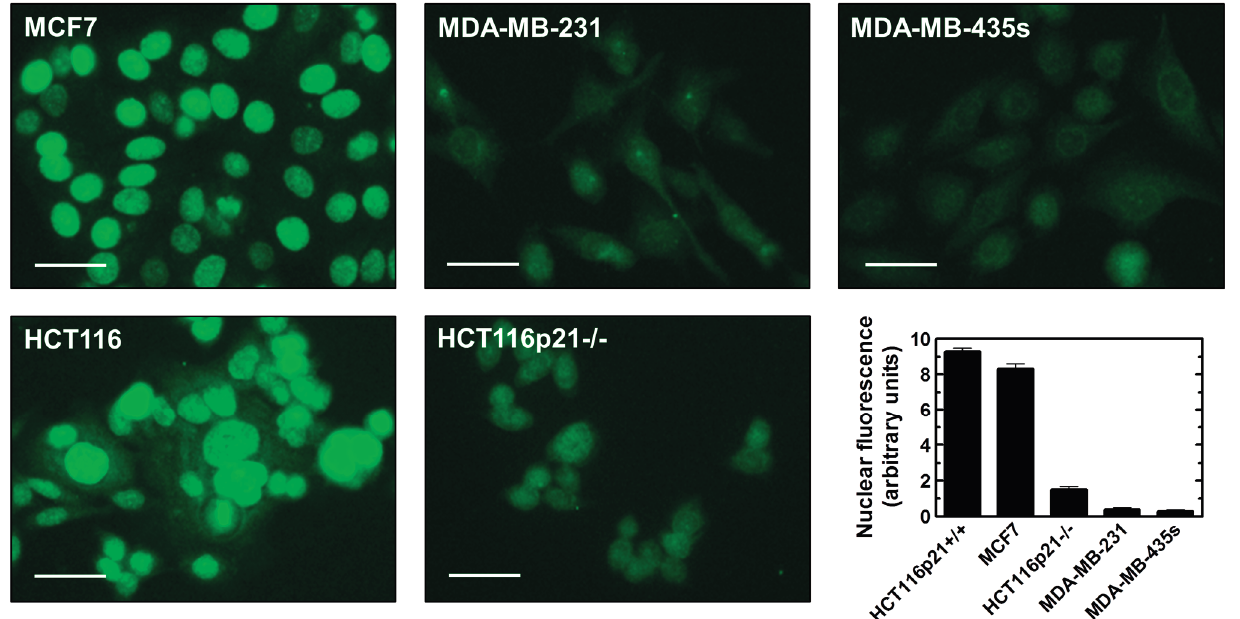
Figure 7. Immunofluorescence analysis of constitutive WIP1 protein levels in the indicated cell lines. Representative images together with densitometric evaluation of intensities of nuclear fluorescence staining are presented. Bars, SE. Scale bar, 20 µm.